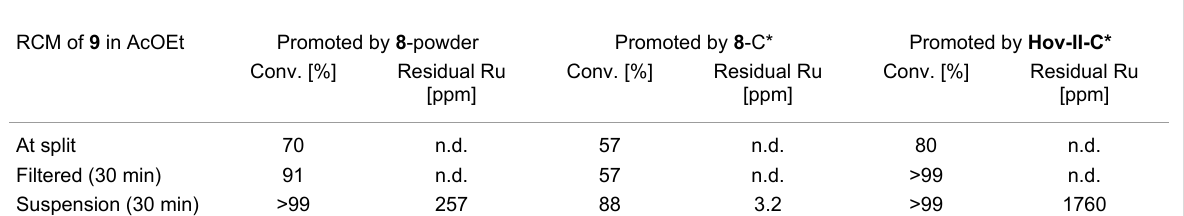
Table 1: Results of olefin metathesis conducted in AcOEt. a